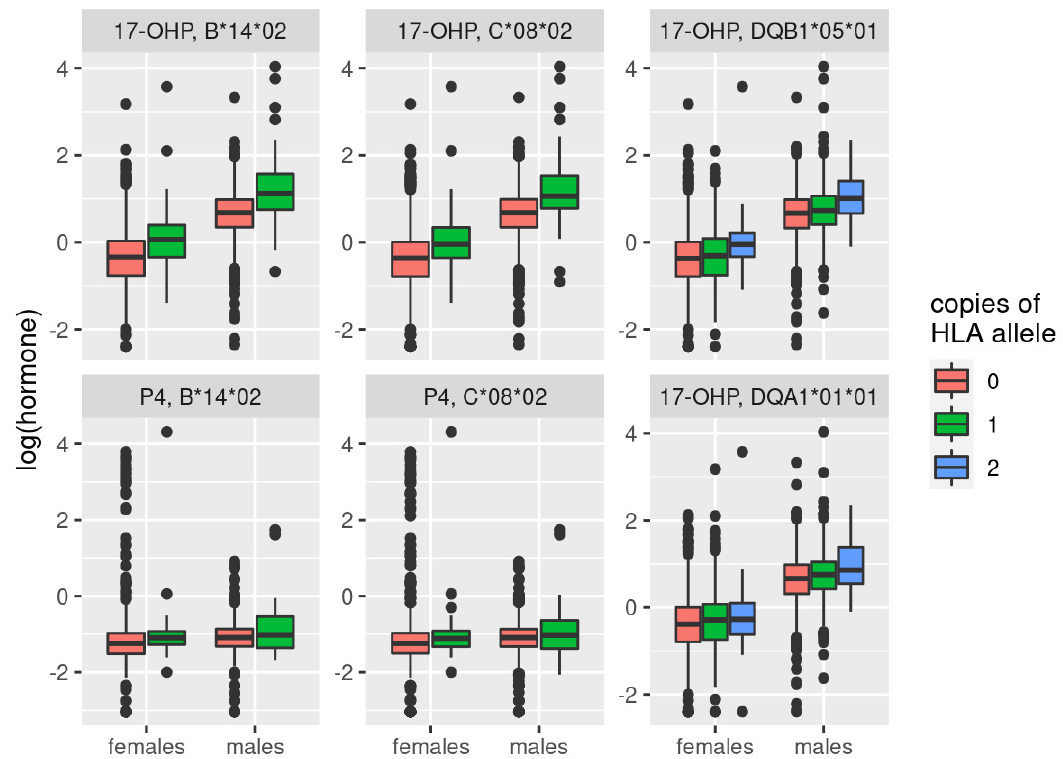
Figure 4. Boxplot of hormone levels for significant associations of HLA subtypes with either 17-OHP or P4. There was only a single male and female sample that had two copies of C*08*02 and B*14*02. For this plot, they were assigned to the group carrying one copy. Data of LIFE-Adult and LIFE-Heart were pooled for this plot, while analyses were performed with a fixed-effect meta-model.